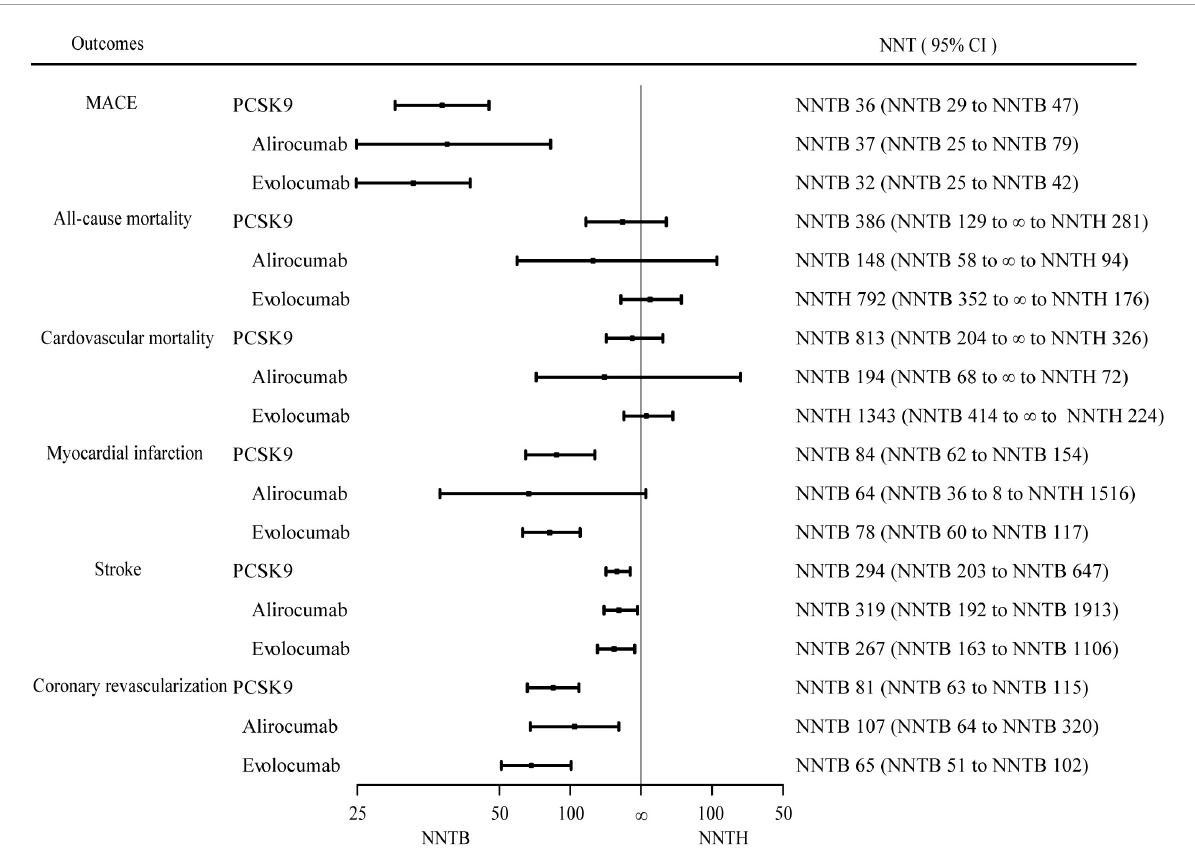
FIGURE2 Efficacy endpoints for PCSK9 inhibitors vs. control. Effect of proprotein convertase subtilisin/Kexin type 9 (PCSK9) inhibitors on major adverse cardiovascular events, all-cause mortality, cardiovascular mortality, myocardial infarction, stroke, and coronary revascularization over 1.56 years. The number needed to treat (NNT) with the corresponding confidence intervals (CIs). MACE, major adverse cardiovascular events; NNT, the number needed to treat; NNTB, the number needed to treat to benefit; NNTH, the number needed to treat to